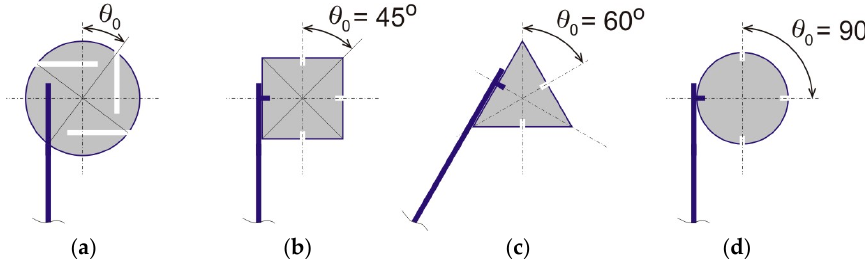
Figure 1. Antichiral metamaterial architecture, enabling negative (effective) thermal expansion. Continuous elastic thermal buckling of the bimetal strips, shown as solid lines, leads to an overall contraction of the material sample with temperature.